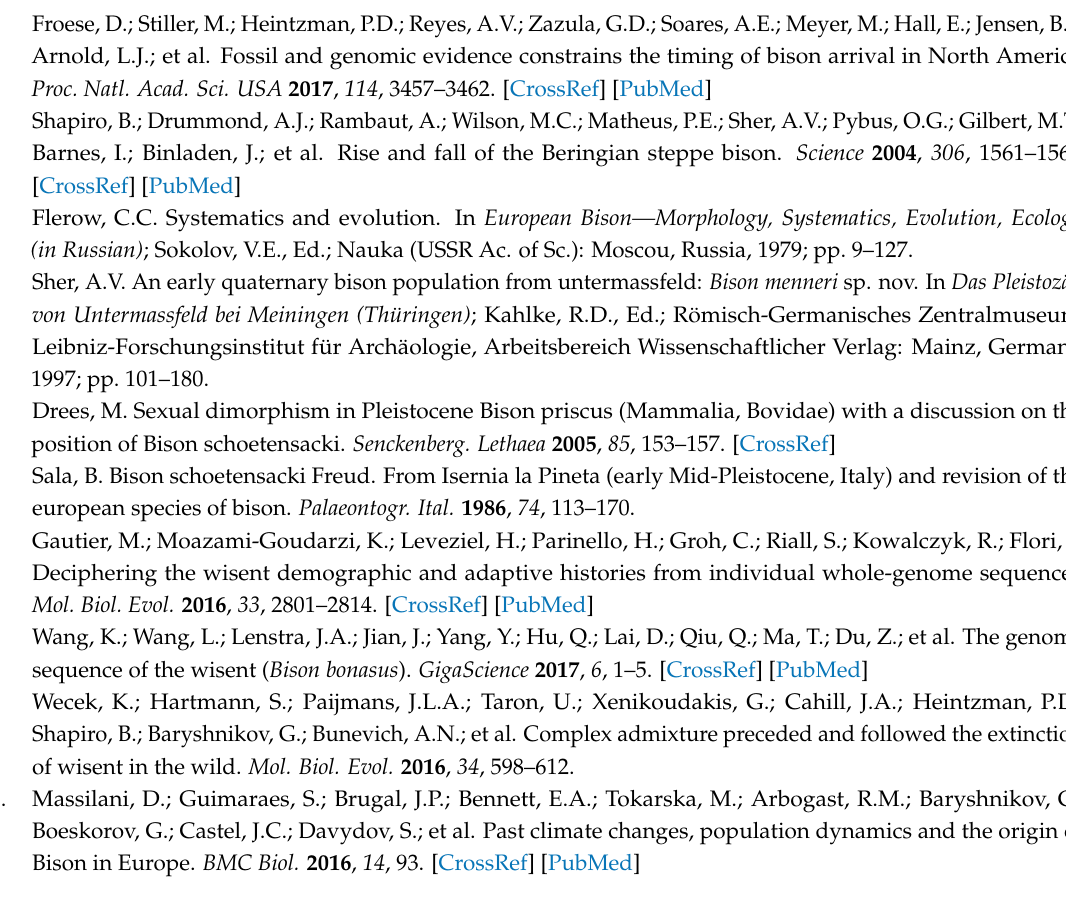
Table S1: Source and description of the samples included in the meta-analysis of nuclear SNP genotypes. Author Contributions: All authors analyzed data and drafted their analyses. T.G. and E.-M.G. wrote the manuscript with input from all